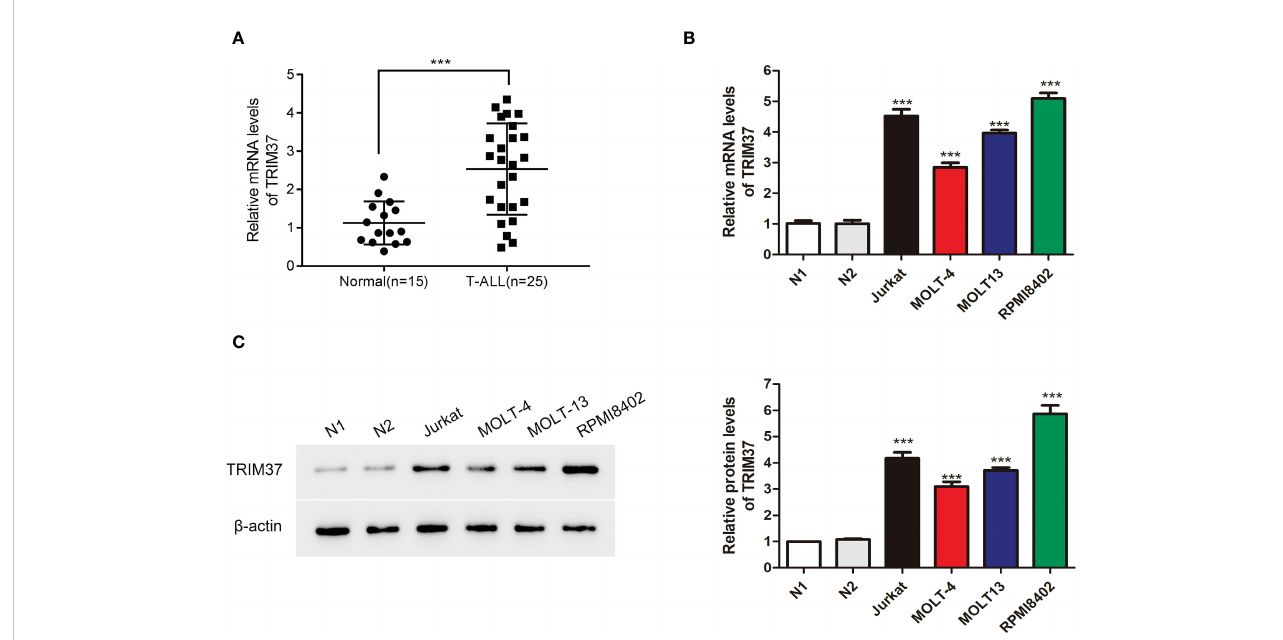
FIGURE 1 TRIM37 expression was elevated in patients with T-ALL and T-ALL cells. (A) The mRNA abundance of TRIM37 in T-ALL patients ( n = 25) and normal individuals ( n = 15) was examined by qRT-PCR. *** p < 0.001, compared with normal group. (B, C) The levels of TRIM37 in Jurkat, MOLT-4, MOLT13, RPMI8402, and two normal cell lines (N1 and N2) were quanti fi ed by qRT-PCR and Western blot assays. *** p < 0.001, compared with N1